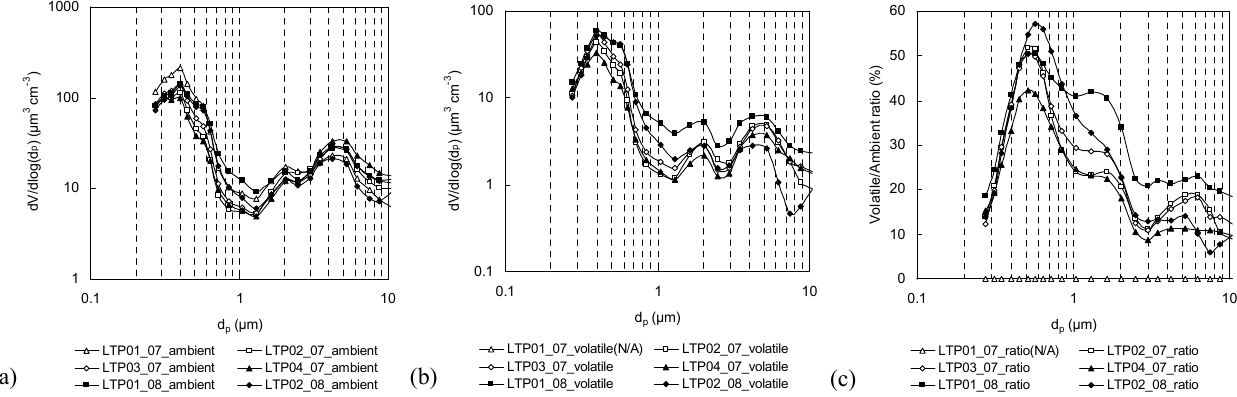
Figure 18. Volume size distribution of (a) ambient, (b) volatile aerosol, and (c) contribution of volatile fraction to ambient aerosol during Fig. 18. Volume size distribution of (a) ambient, (b) volatile aerosol, and (c) volatile fraction to ambient aerosol during the LTP the LTP periods.